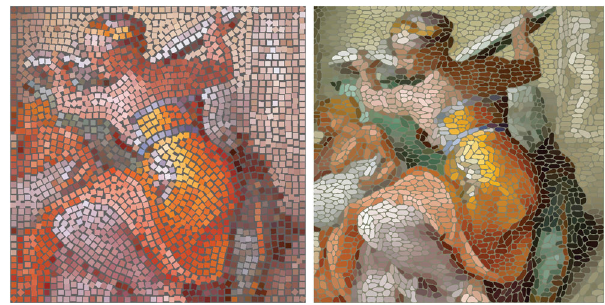
Fig. 14 Pebbles within the important area (inset) are rendered at a higher frequency.